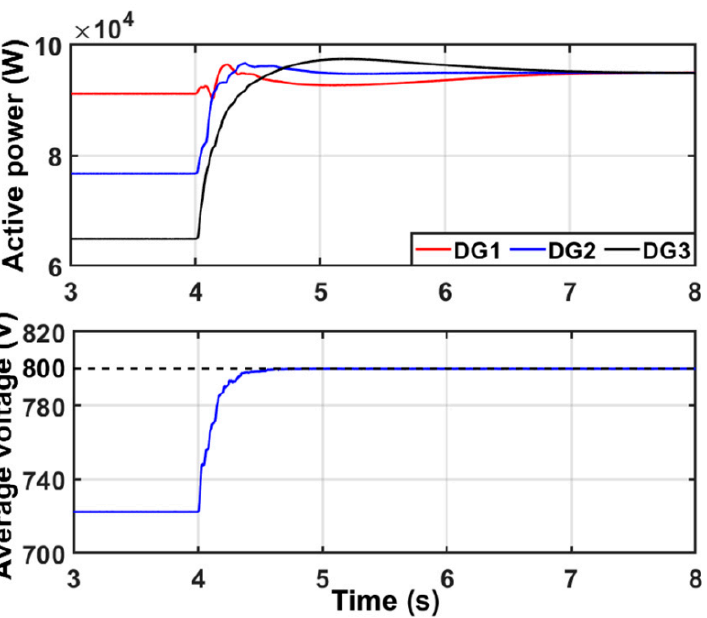
Figure 12. Simulation results in case of topology switch under proposed